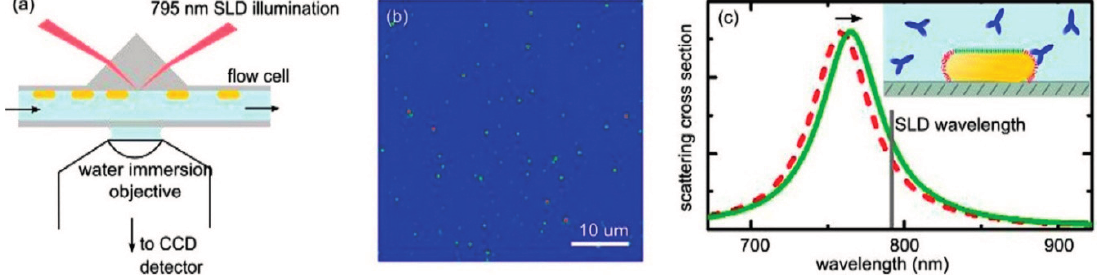
Figure 4. ( a ) The optical setup for the total internal reflection and illumination of a single gold nanorod (magnified) for the detection of single protein binding. Inset at the top left is the theoretical LSPR shift that is expected in response to a large increase in local refractive index, such as the binding of proteins. Top panel in ( b ) shows the spectrum of a single Au nanorod, before and after the binding of single proteins. The bottom panel in ( b ) shows the difference in intensity between pre and post-binding of the protein; ( c ) The resonance wavelength of the single Au nanorod, monitored as a function of time, shows multiple single protein binding events, while the resonance wavelength remains flat for the protein-free solution. The peaks in the histogram ( d ) correspond to single protein-binding events. Reprinted with permission from [70]. Copyright 2012 American Chemical Society.